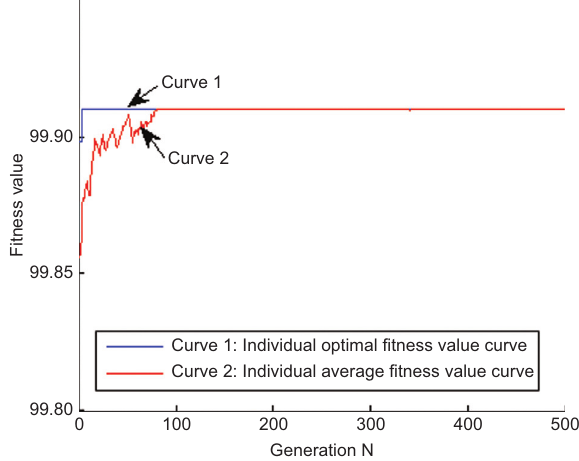
curveCurve 1: Individual optimal fitness value Curve 2: Individual average fitness value